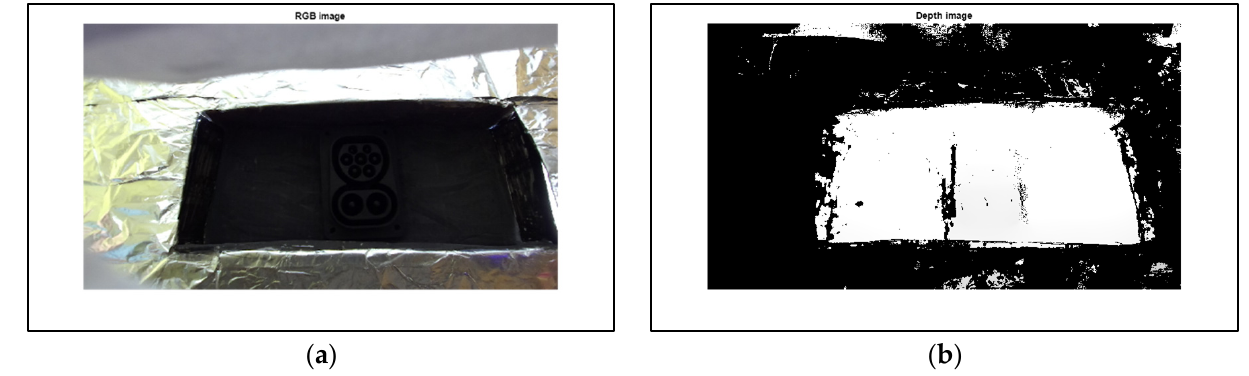
Figure 4. ( a ) RGB image and ( b ) original input depth map converted to 8-bit depth resolution. In order to enhance the contours of the connector, the input RGB image has been converted to grayscale image, and next the grayscale dilation operation is performed on the grayscaled input image [13]. Basically, the grayscale dilation is a local-maximum operation, where the maximum is taken over a set of pixel neighbors defined by the spatial shape of the elements with value 1 in the domain of the structuring element (SE)